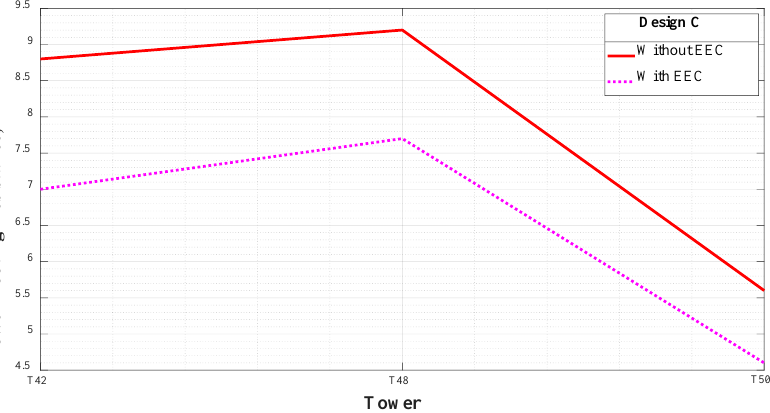
Figure 12. Comparison of the TFR value with and without EEC implementation for Design C.